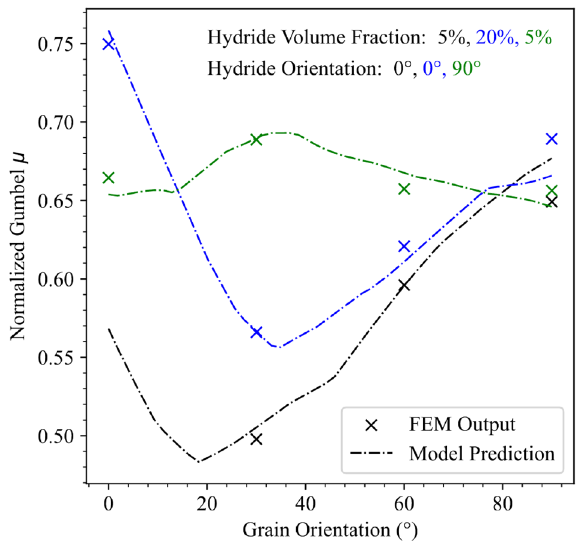
Figure 3. Model verification as a functions of grain orientation . The colors denote a subset of material parameters as referenced in the legend in the top right. Variations in hydride volume fraction and hydride orientation are also included. FEM output data is not shown for the 5% HVF, 0° hydride orientation, 0° grain orientation case because that case was not part of the training dataset.